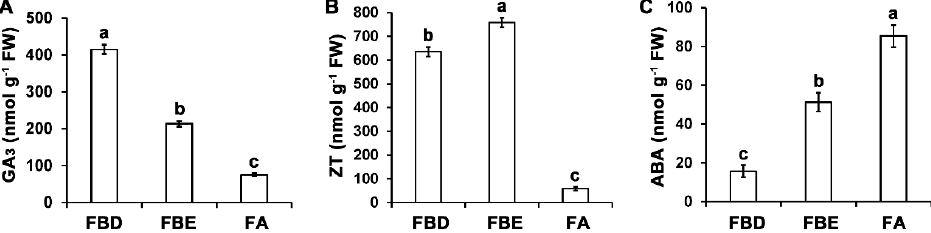
Figure 11. Changes in GA 3 , zeatin (ZT), and ABA concentrations during flower development. ( A ) GA 3 concentration. ( B ) ZT concentration. ( C ) ABA concentration. Significant differences are indicated by different letters ( p < 0.05).